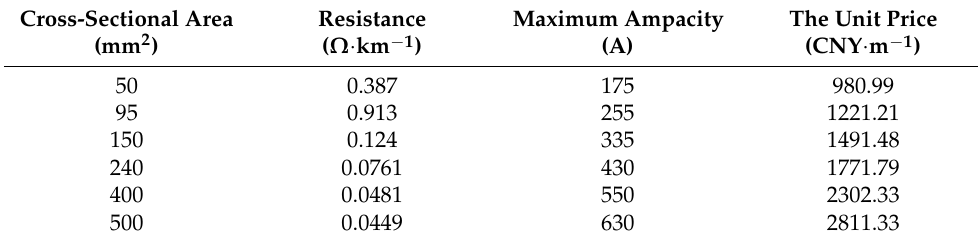
Table 2. Parameters of cables.